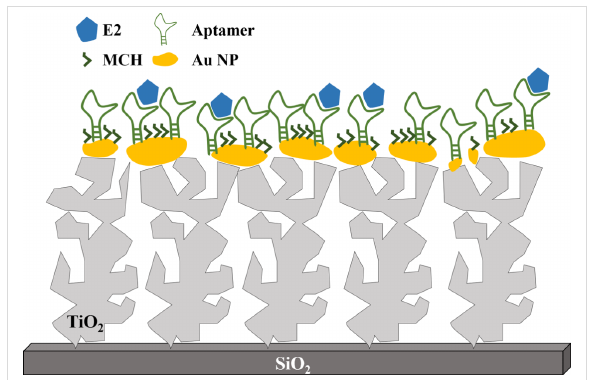
Figure 1: Schematic of the SERS sensor. The figure is not to scale for the sake of